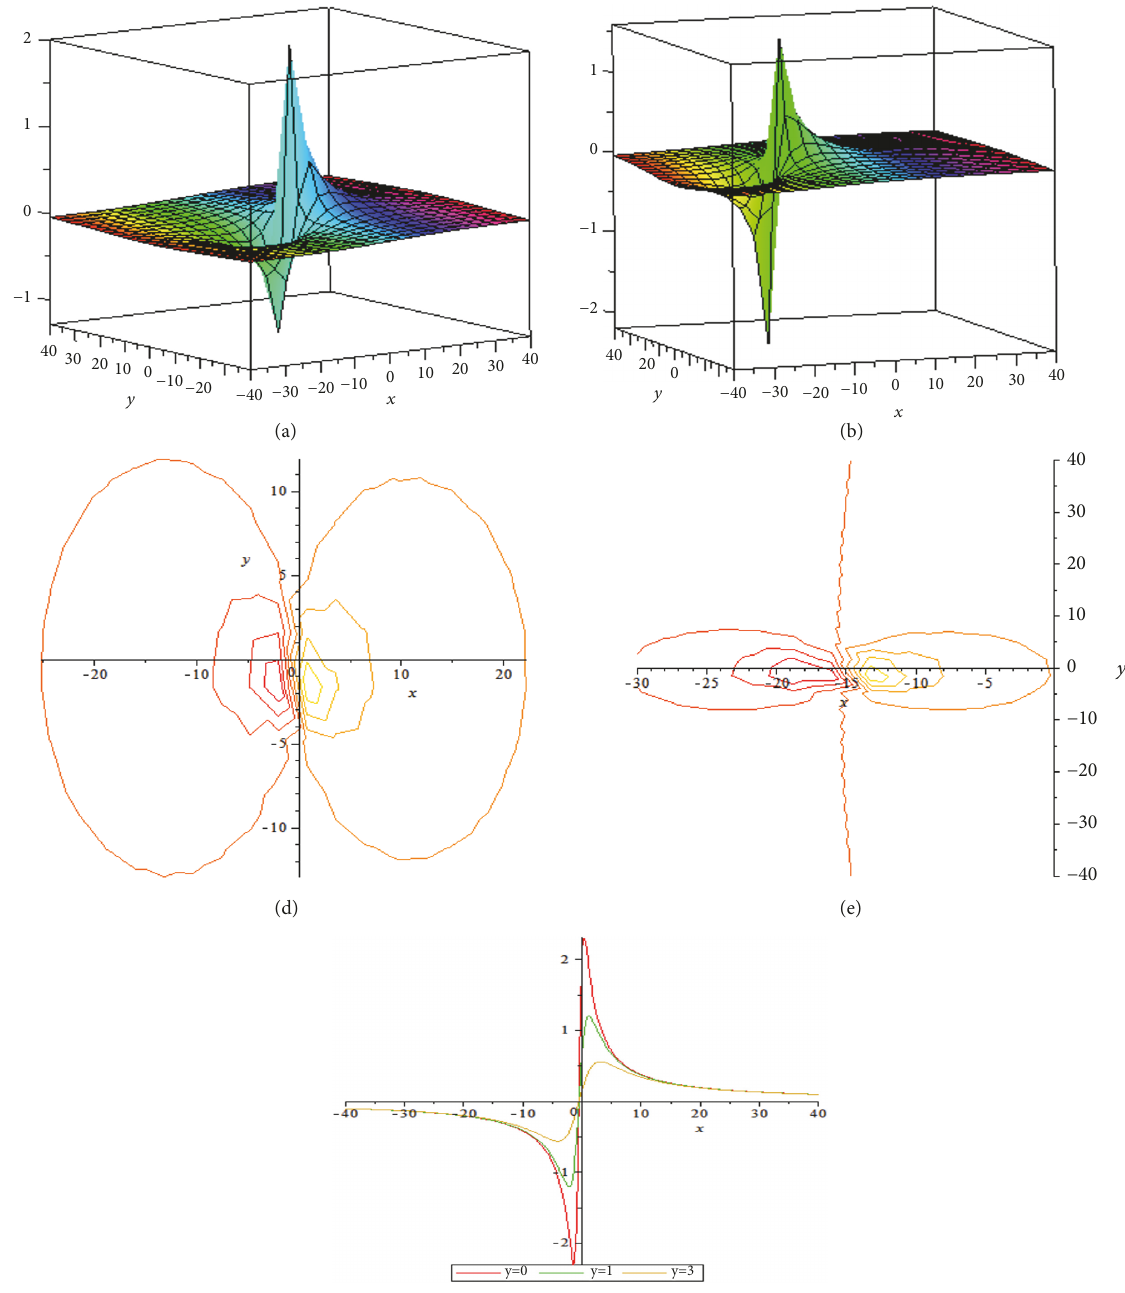
Figure 1: Proportion sight of the solution equation (8) with (6) and (5). For arbitrary constant values, 𝛼 2 = 𝛼 1 = 1, 𝛼 7 = −1,𝛼 6 = 1,𝛼 10 = 0,𝛼 = 1 , and 𝛼 = 5. (a-b) 3D plots for 𝑡 = 0 , and 3, respectively. (d-e) Consistent contour plot of (a), (b). 2D plot present in (f) for various 11 8 values of